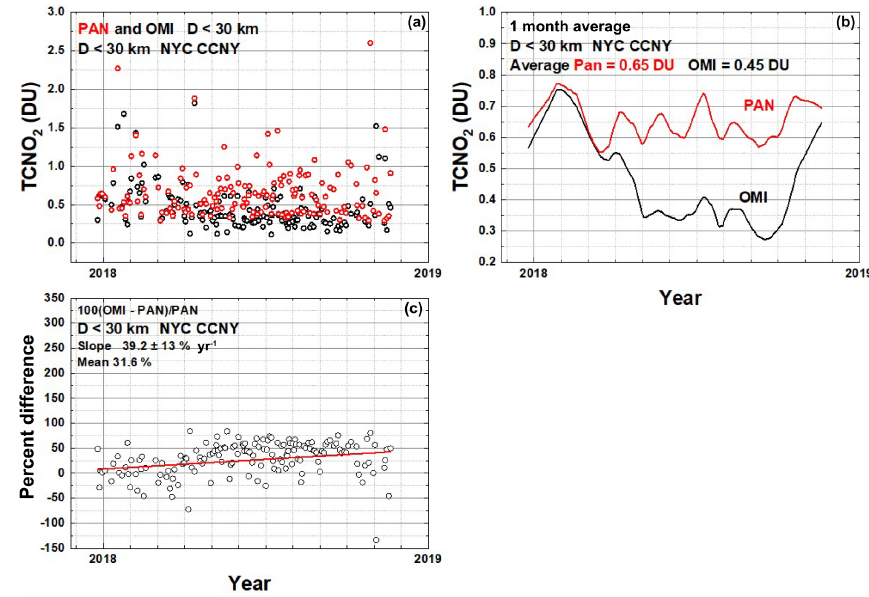
Figure 10. TCNO 2 overpass time series for CCNY in Manhattan, New York City. (a) OMI overpass TCNO 2 (black) compared with OMI (red). (b) Monthly lowess (0.08) fit to the daily overpass data. (c) Percent difference 100(OMI–PAN)/PAN calculated from the data in (a)